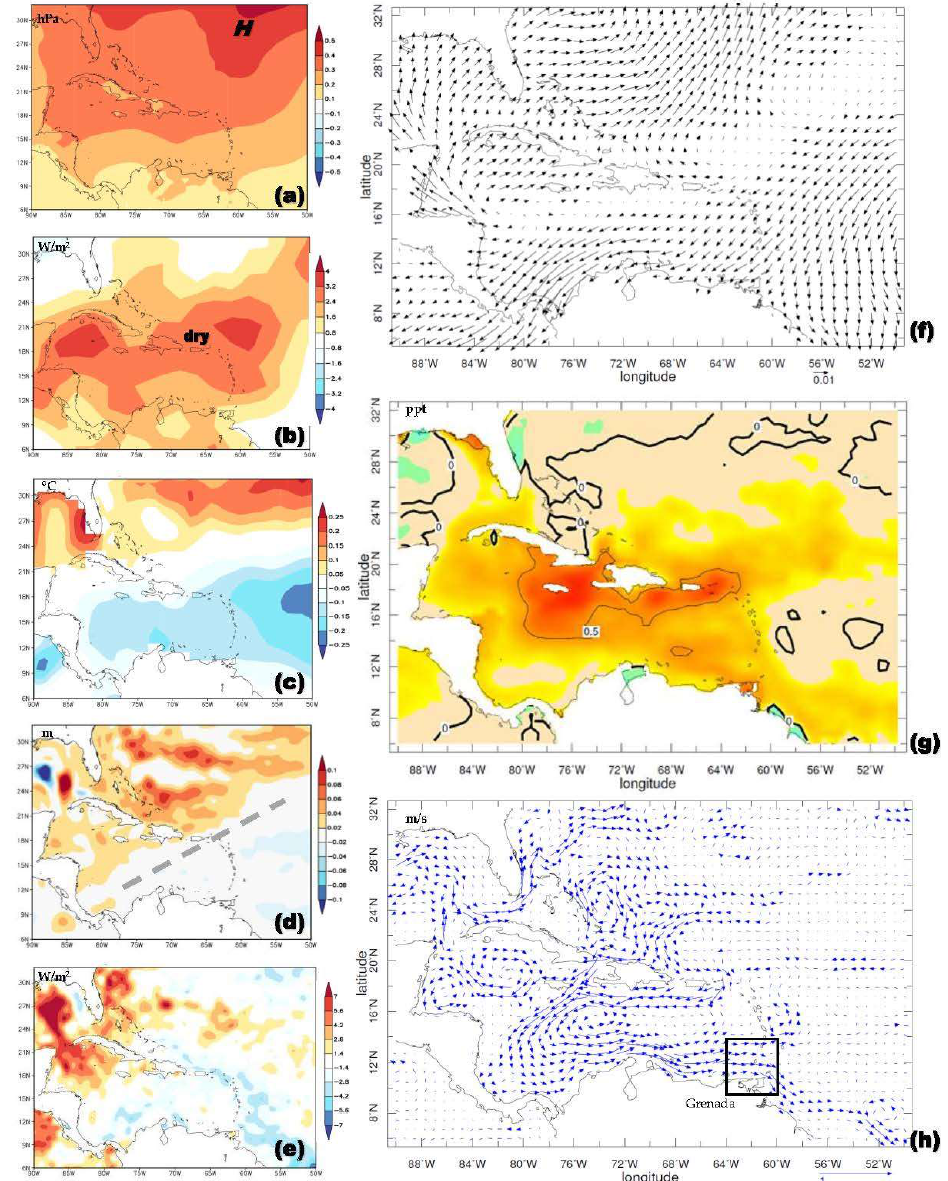
Figure 3. Regression of monthly current EOF mode-1 score for the period 1980–2015 onto monthly field anomalies of: ( a ) SLP, ( b ) netOLR, ( c ) SST, ( d ) SSH, ( e ) net heat flux, N = 430. Right column, composite high minus low inflow (based on Table 2a): ( f ) SODA3 wind stress (N/m 2 ), ( g ) 1–100 m salinity, ( h ) 5–200 m currents, with Grenada index box. Label in ( a ) is high pressure; diagonal line in ( d ) denotes the SW-oriented SSH ridge. Insignificant field values are neutral shaded, units are listed in upper left of panels.